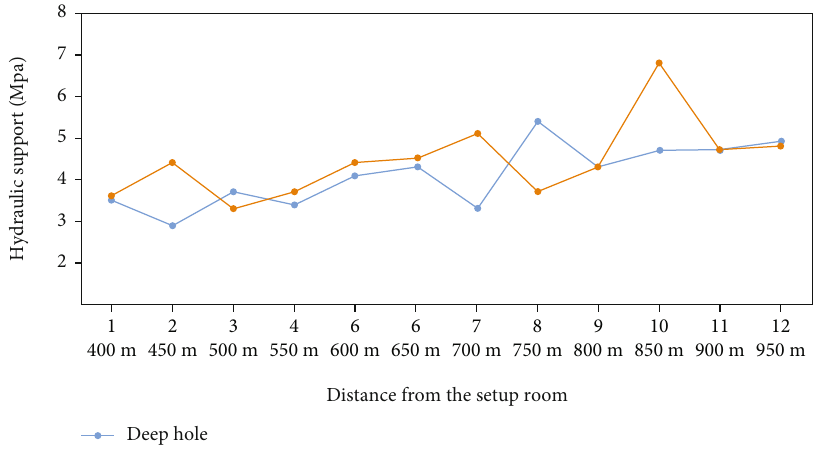
Figure 12: 42108 broken line chart of surrounding rock stress at the main auxiliary